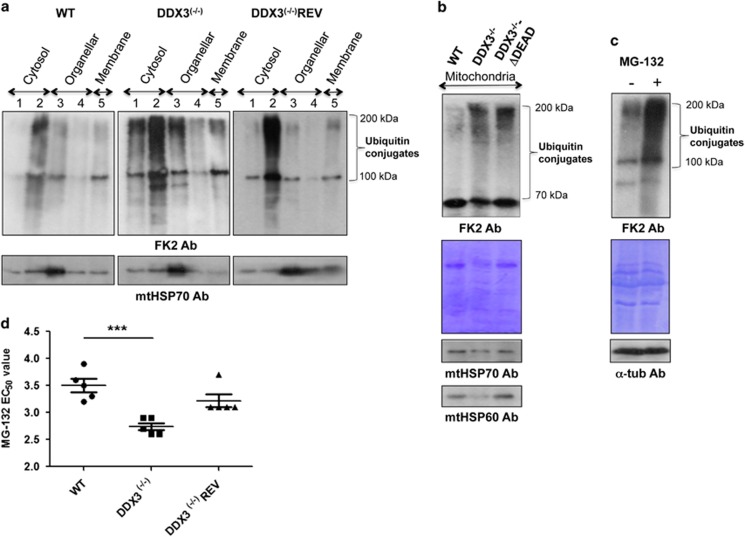
DDX3 inactivation results in the accumulation of mitochondrial polyubiquitinated proteins. (a) Digitonin (20 μM–10 mM) fractions (equal volume) isolated from the same number of WT, DDX3(−/−), and DDX3(−/−)REV parasites were analyzed by western blotting using the FK2 antibody recognizing K29-, K48-, and K63-linked mono- and polyubiquitinated proteins. As also determined by our previous experiments,59 digitonin fractions 1 and 2 are enriched with cytosolic proteins, fractions 3 and 4 with organellar material, and fraction 5 with membrane-associated proteins. An antibody directed against the mtHSP70 protein was used as a control to confirm mitochondrial enrichment in fraction 3. (b) Mitochondria purified from the same number of WT, DDX3(−/−), and DDX3(−/−)-ΔDEAD (DDX3(−/−) rescued with the DDX3ΔDEAD mutant) parasites using a 20–35% Percoll gradient centrifugation were analyzed by western blotting using the FK2 antibody. An equal amount of proteins was loaded on the gel. Shown here is one representative experiment out of three yielding similar results. (c) Western blot of total lysates from L. infantum WT treated with the proteasome inhibitor MG-132 (10 μM) using the FK2 antibody. The anti-α-tubulin antibody and Coomassie blue staining were used as loading controls. (d) Susceptibility of WT, DDX3(−/−), and DDX3(−/−)REV strains to MG-132.